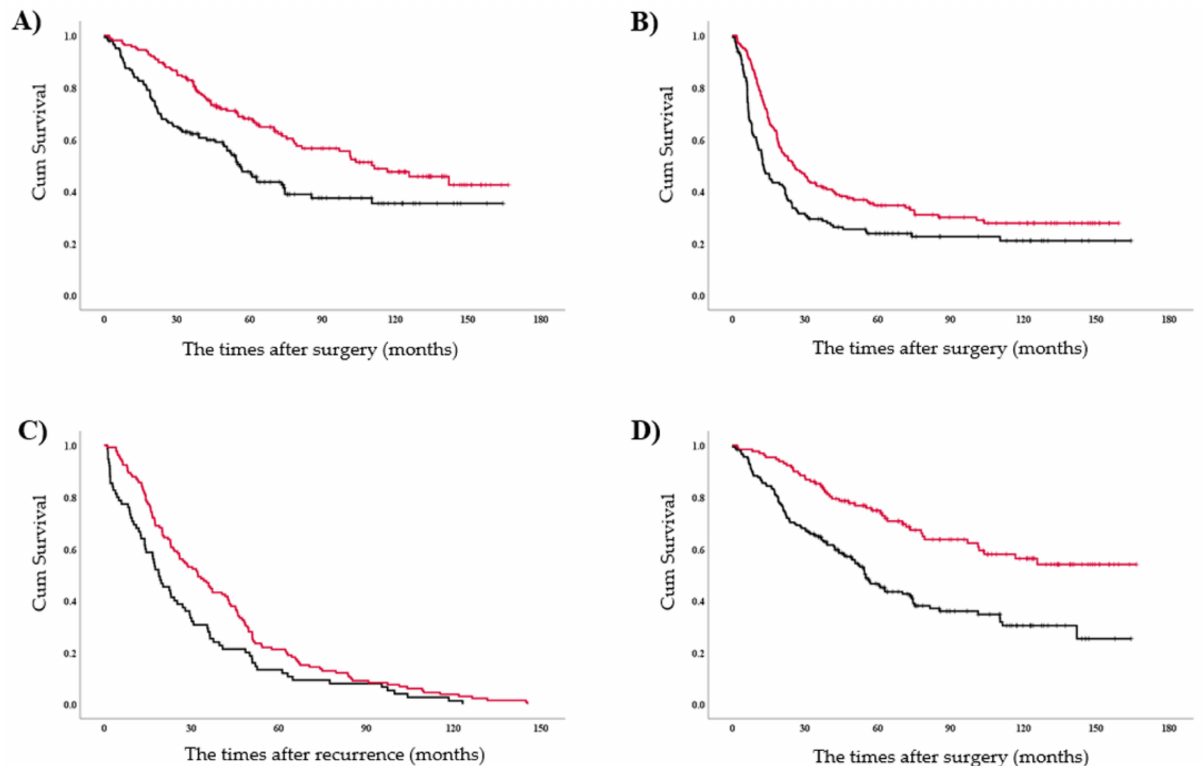
Figure 2. Kaplan–Meier curves. ( A ) Overall survival curve and ( B ) disease-free survival curve after surgical tumour resection stratified according to the adjuvant treatments. Red and black lines represent with and without adjuvant treatments, respectively. ( C ) Overall survival curve after recurrence stratified according to the guideline matched first-line treatment for recurrence. Red and black lines represent yes and no, respectively. ( D ) Overall survival after surgical tumour resection. Red and black lines represent guideline-consistent and guideline-inconsistent cases,